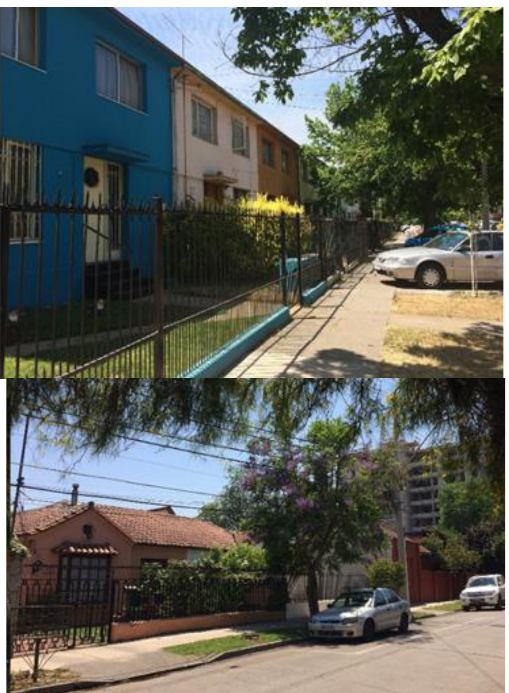
Figure 10 & 11. Formal-traditional habitat in Santiago, Chile (Gómez, 2015).